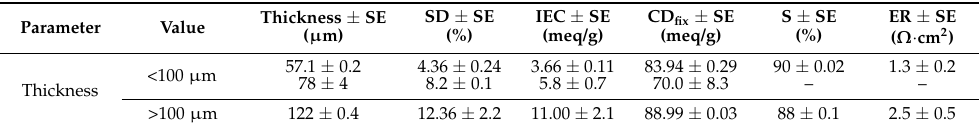
Table 7. Values for SD, IEC, CD fix , permselectivity (S) and membrane electrical resistance (ER) in function of membrane thickness.